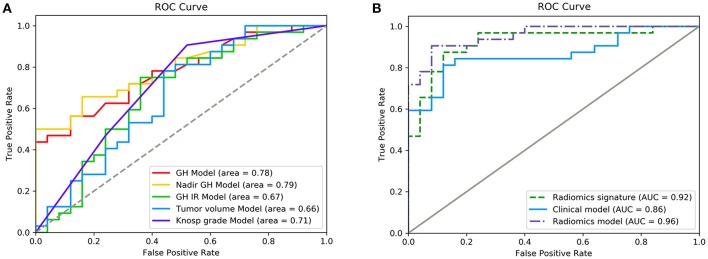
ROC curves showing the performance of different features and models in the prediction of response to radiotherapy. (A) Diagnostic performance of each independent clinical feature. (B) Diagnostic performance of the radiomics signature, clinical model, and radiomics model. Radiomics features had significantly higher AUC values than the clinical model (p = 0.011).